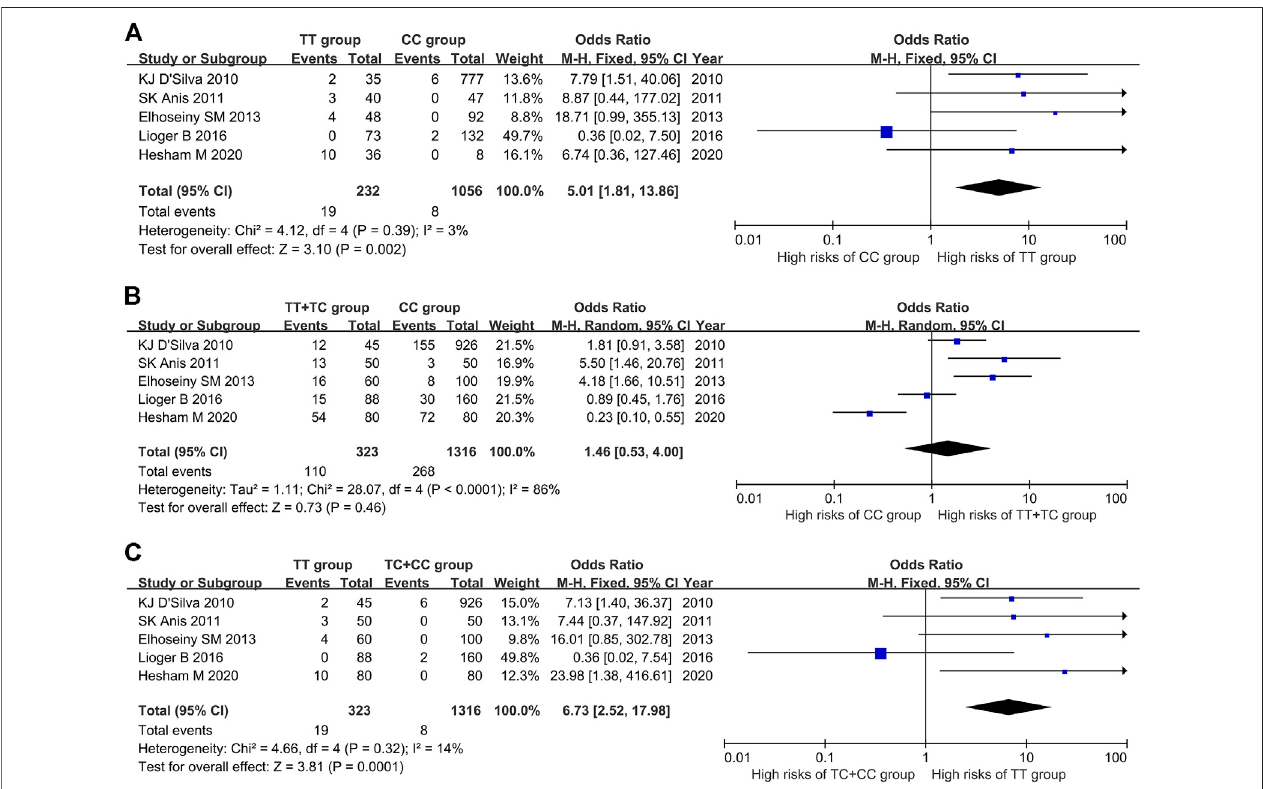
FIGURE 2 | Meta-analysis of correlation between PTPN22 gene SNP1858 and ITP. (A) TT vs CC. (B) TT + TC vs CC. (C) TT vs TC + CC.